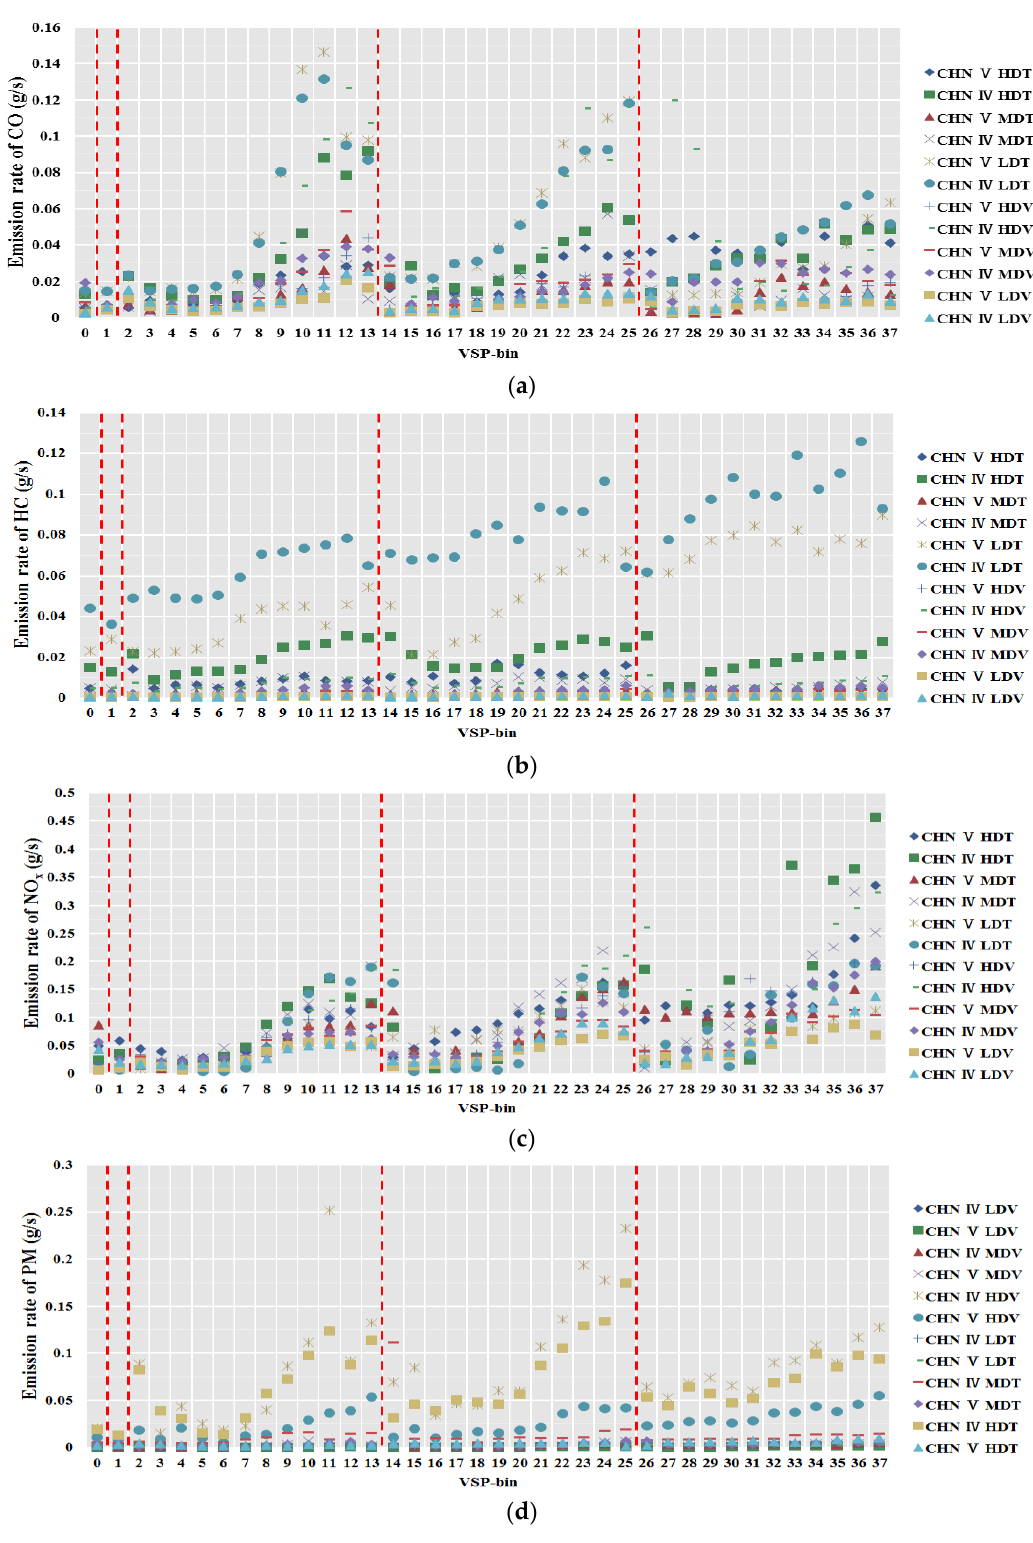
Figure 12. The vehicle emission rate (g/s) based on VSP-bin. ( a ) CO emission rate (g/s) based on VSP-binl; ( b ) HC emission rate (g/s) based on VSP-bin; ( c ) NO x emission rate (g/s) based on VSP-bin; ( d ) PM emission rate (g/s) based on VSP-bin; the areas divided by 4 red dotted lines from left to right corresponds to 5 speed intervals (i.e., “ Deceleration ” , “ Idling ” , “ Low speed ” , “ Middle speed ” , and “ High speed ” ) in VSP-bin division standard respectively.